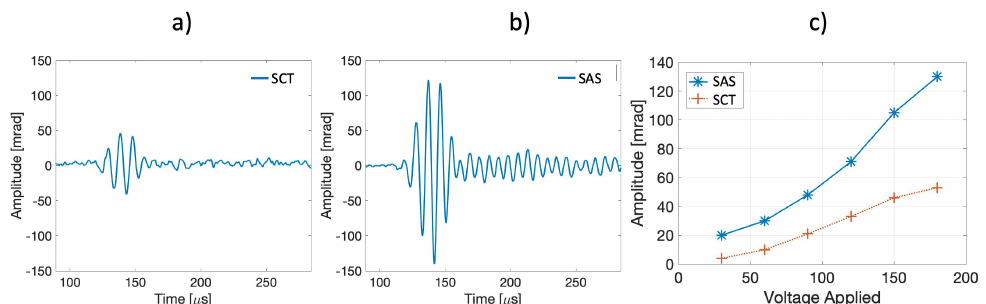
Figure 3. The recovered signal in the case of the ( a ) SCT configuration and ( b ) SAS configuration, ( c ) comparison between the detected amplitude as a function of different five-cycle toneburst ampli- tudes.